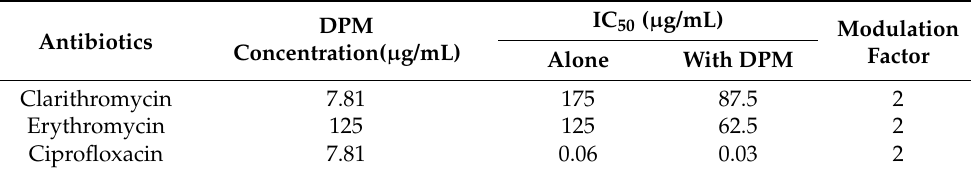
Table 1. Modulation activity of diphenylmethane for the antibiotics against E. coli Kam3-AcrB.